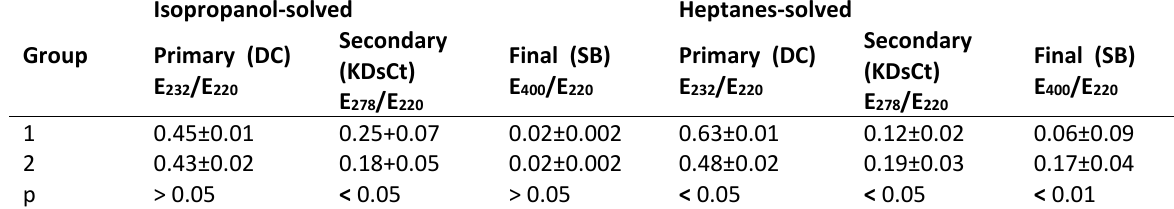
Table 1. Content of lipid peroxidation molecular products at competition stage of training in both groups (М±m) Isopropanol-solved Group